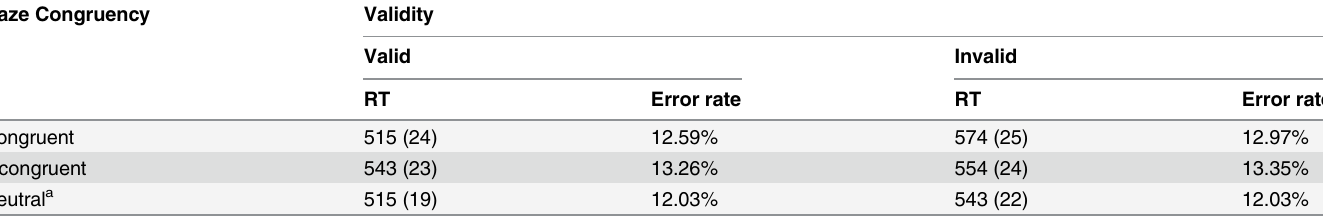
Table 2. Group average RTs and error rates Experiment